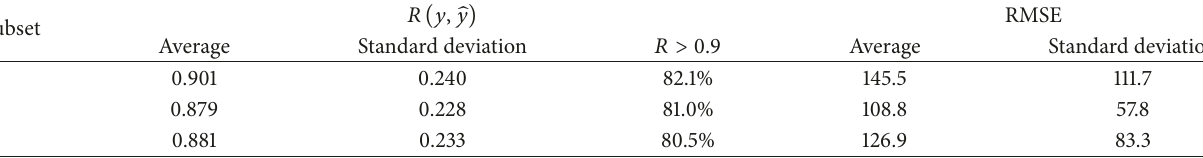
Table 6: Summary of the initial training of ANNs for MLP networks (source: own study).